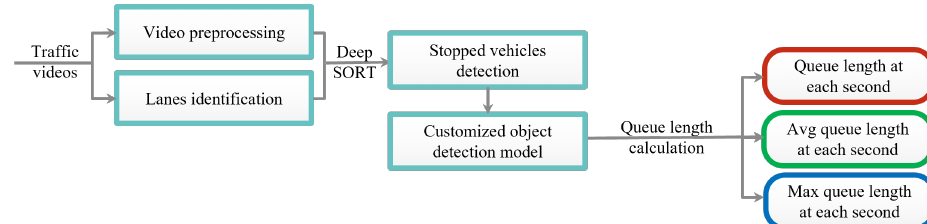
Figure 2. Proposed queue length estimation